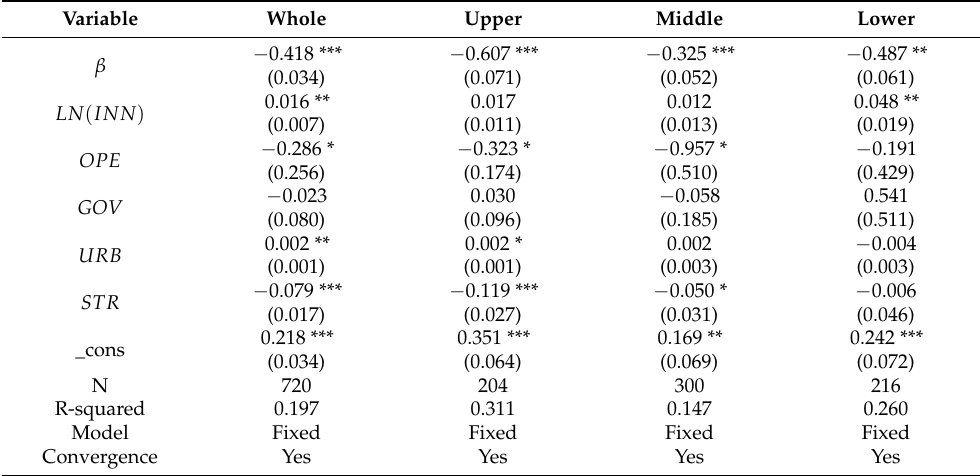
Table 8. Conditional β -convergence test results for the YRB during the period from 2006 to 2018.